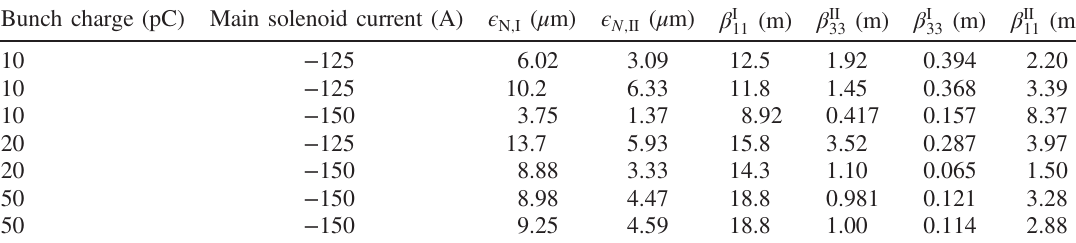
TABLE II. Beam emittances and optics parameters with different bunch charges and main solenoid strengths, with bucking coil current at the nominal − 2 . 2 A. Note that measurements for some settings of the bunch charge and main solenoid strength were repeated (in particular: 10 pC bunch charge and − 125 A main solenoid current; and 50 pC bunch charge and − 150 A main solenoid current), to indicate the reproducibility of the tomography analysis for given machine settings. Bunch charge